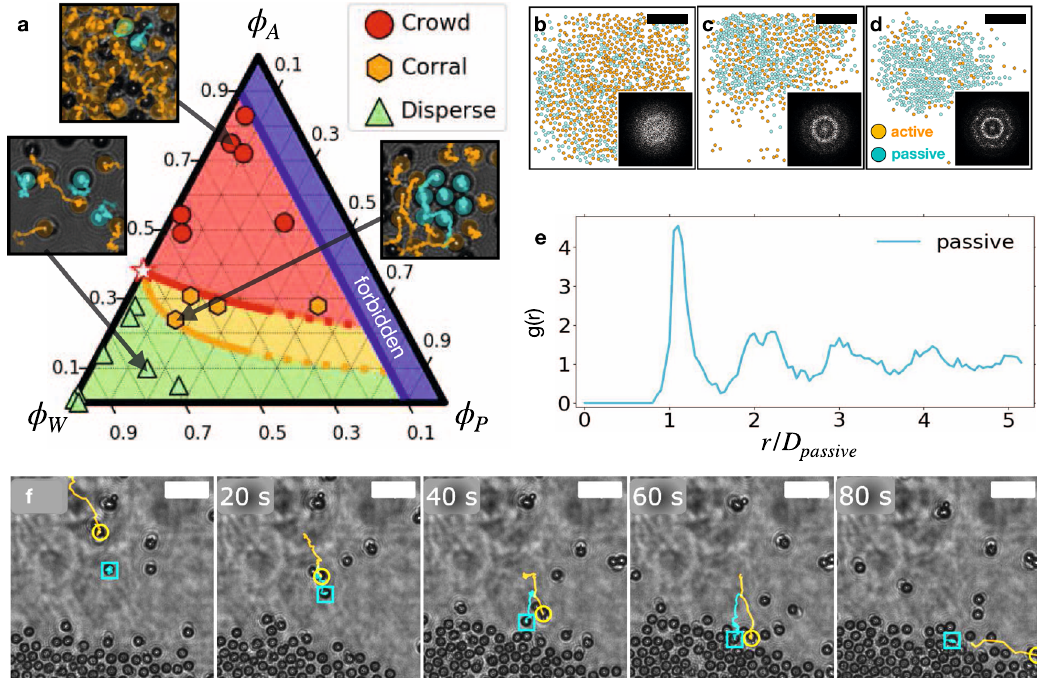
ffiffiffi p ϕ 12 P , a yellow region emerges (see Eq. (2)), π (cid:3) (cid:2) q ! , of the passive particles, showing the evolution ffiffiffi p 3 splitting around 2